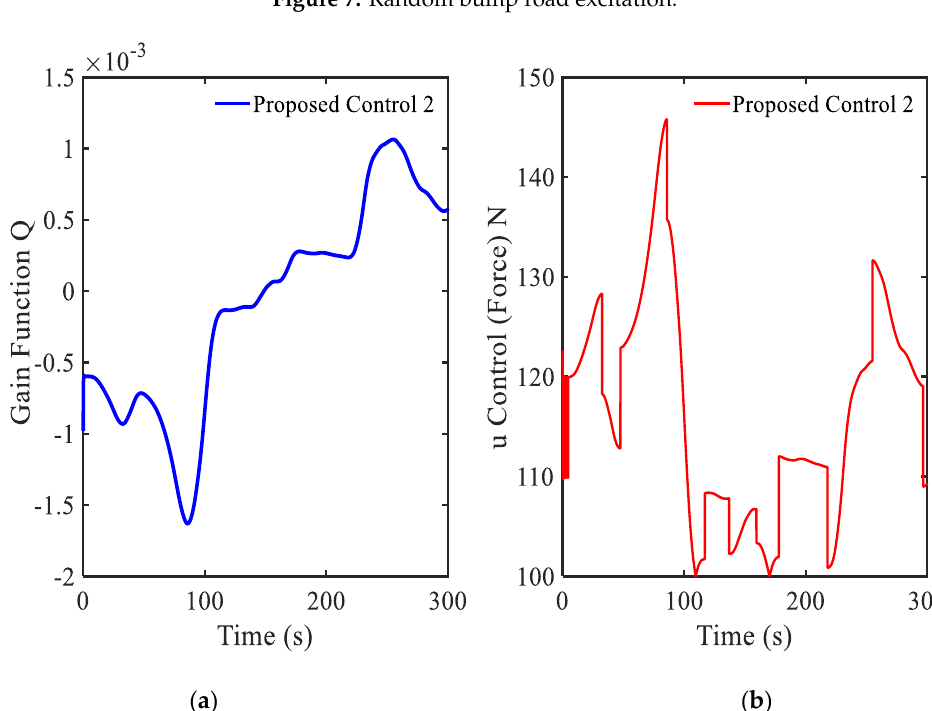
Figure 8. Control results under random bump road excitation: ( a ) gain function Q ∆ L ( t ) , ( b ) main control u ∗ ( t )